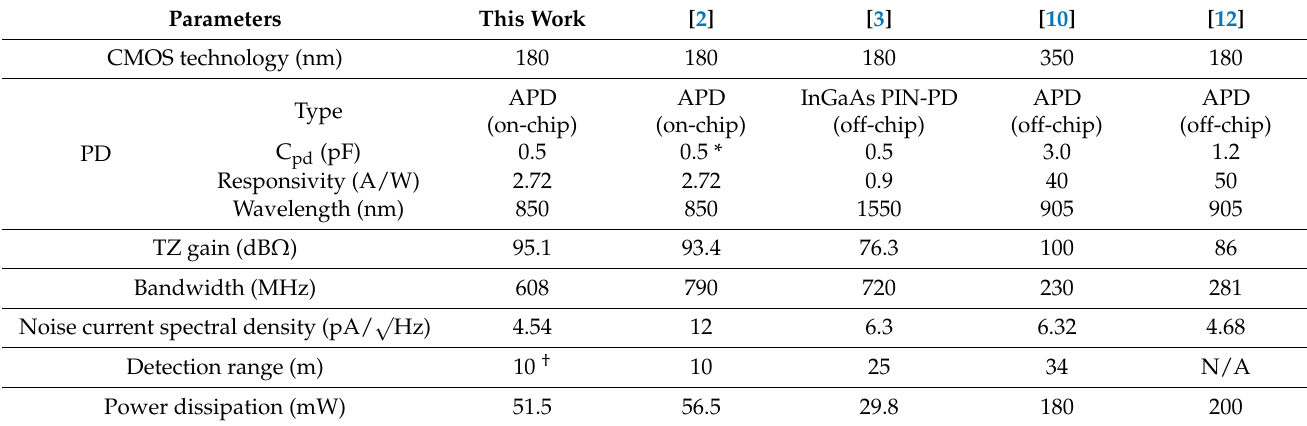
Table 1. Performance Comparison of the Proposed LiDAR AFE IC with Other Prior Arts.